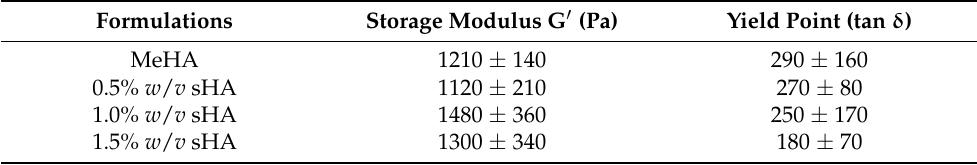
Table 3. The mechanical analysis of four types of hydrogel formulations. Formulations